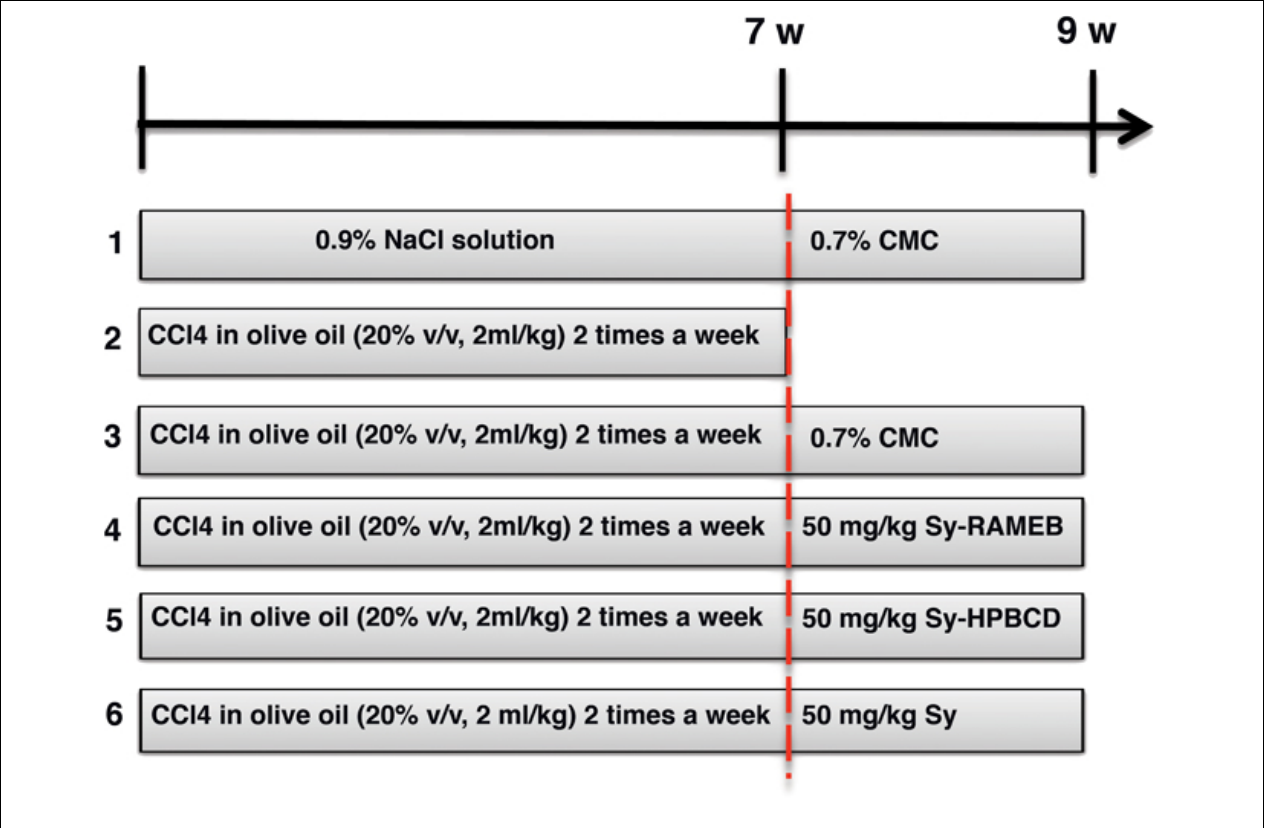
FIGURE 1 | Schematic diagram of the experimental